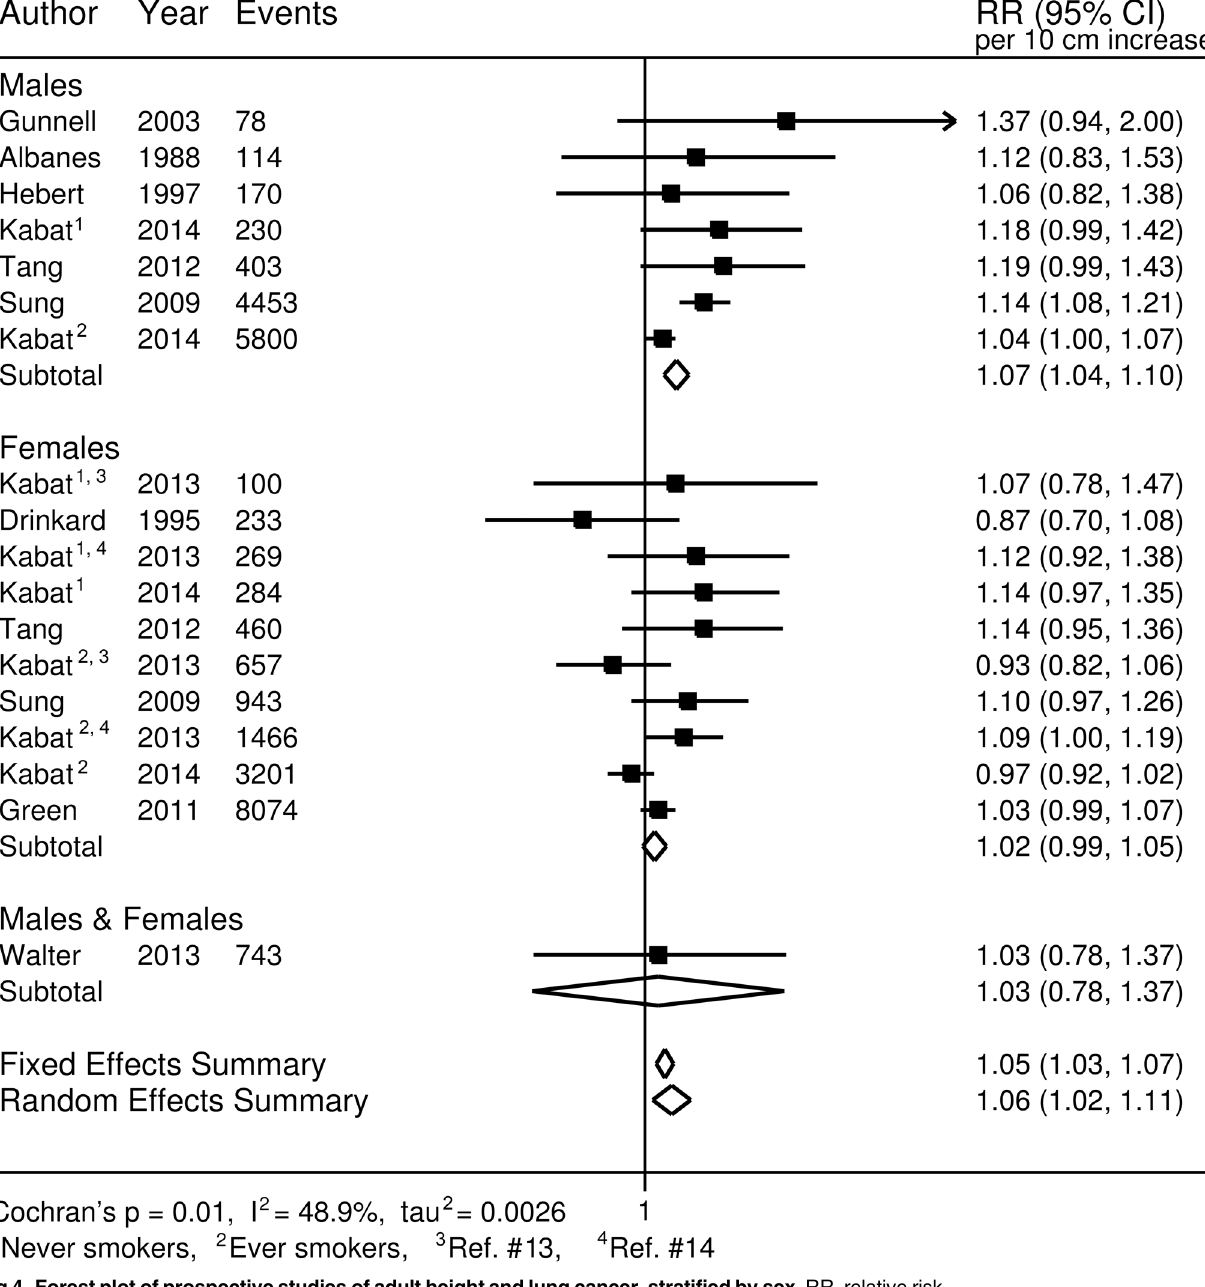
Fig 4. Forest plot of prospective studies of adult height and lung cancer, stratified by sex. RR, relative risk.